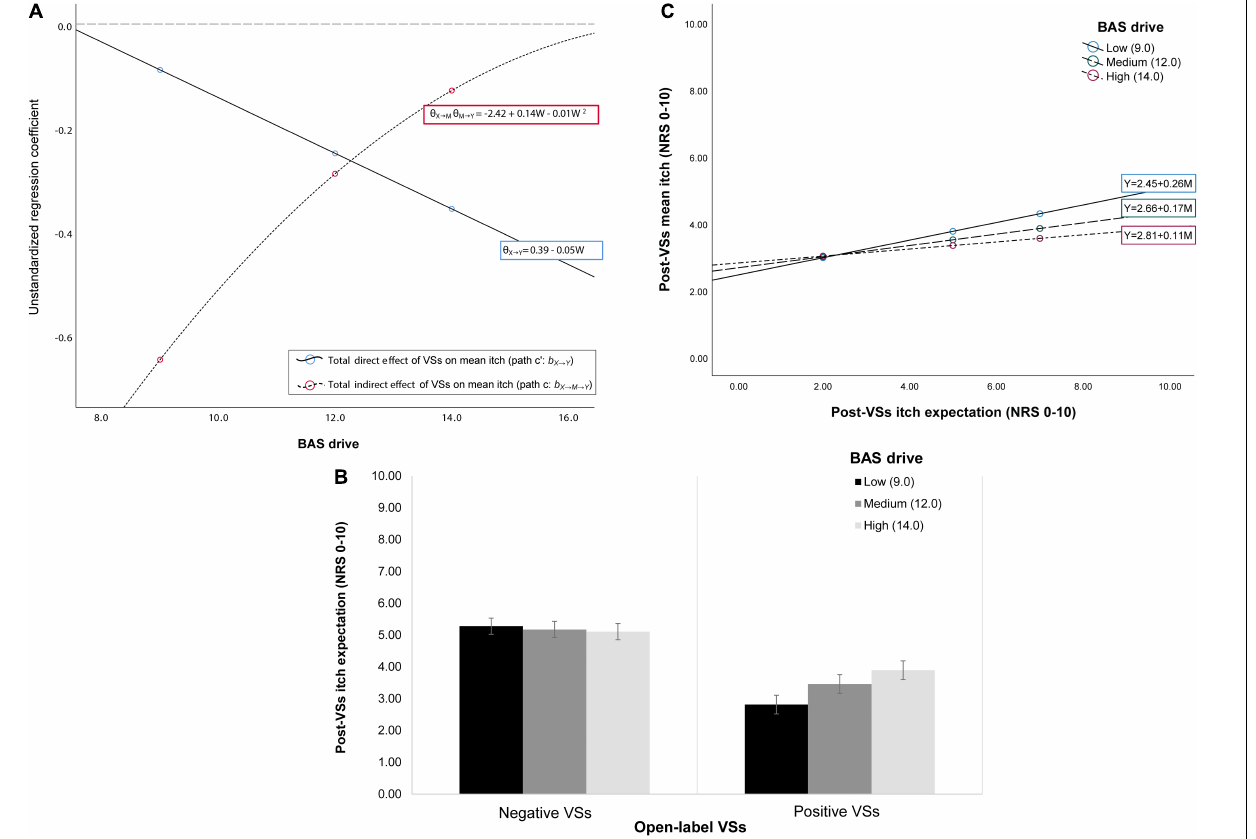
Frontiers in Psychology |